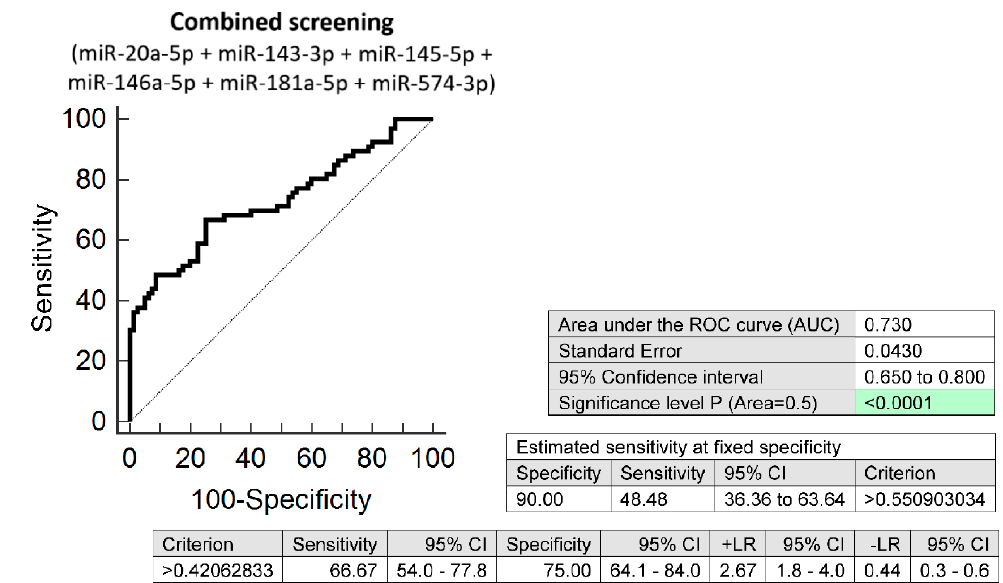
Figure 2. ROC analysis—the combination of microRNA biomarkers. The combination of miR-20a-5p, miR-143-3p, miR-145-5p, miR-146a-5p, miR-181a-5p, and miR-574-3p showed that at 10.0% FPR 48.48% normotensive women subsequently developing PE w/wo FGR had aberrant microRNA expression profile in peripheral blood leukocytes in early stages of gestation. Green colour highlighted significant p -value.